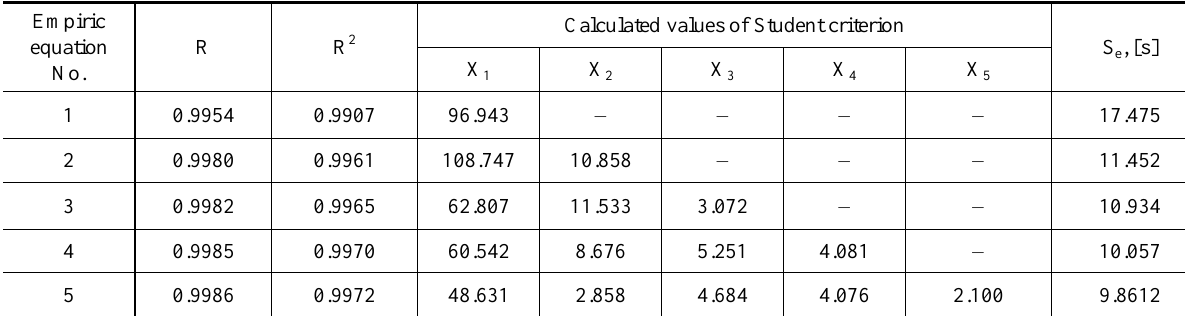
Table 3. Statistic parameters of empiric equations (1)–(5) Empiric